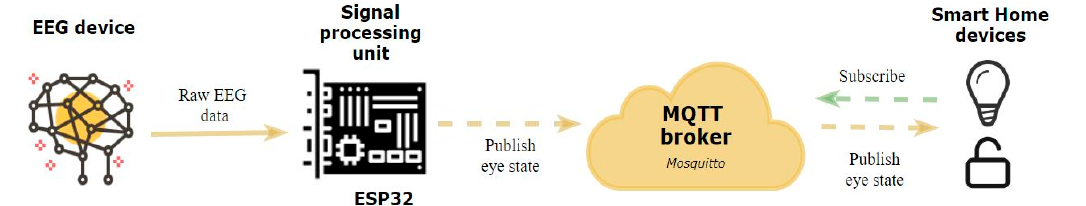
Figure 1. Scheme of the system developed for the integration of BCI and IoT.